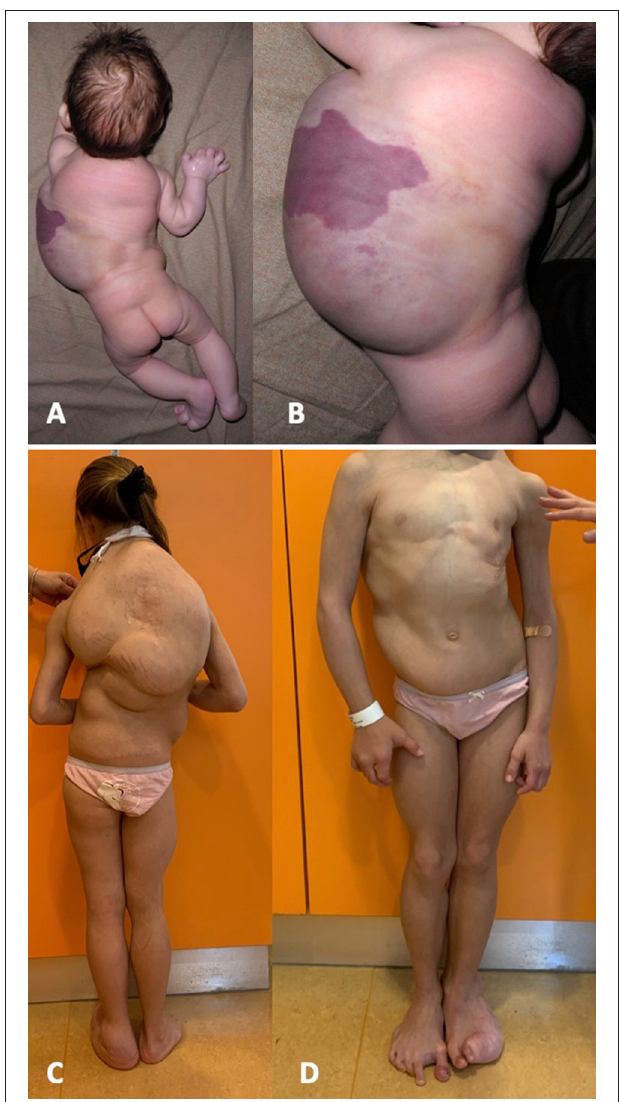
FIGURE 1 | Representive pictures of our patient at birth (A,B) and at the age of 8 years (C,D) . She was born with a thoraco-abdominal large lymphangioma, covered by a capillary malformation, and hypertrophy of the left foot. She developed a severe dorsal scoliosis and a progressive overgrowth of the fibroadipose tissue, mainly localized at the trunk and at the left foot, with evident sandal gap at the right foot.